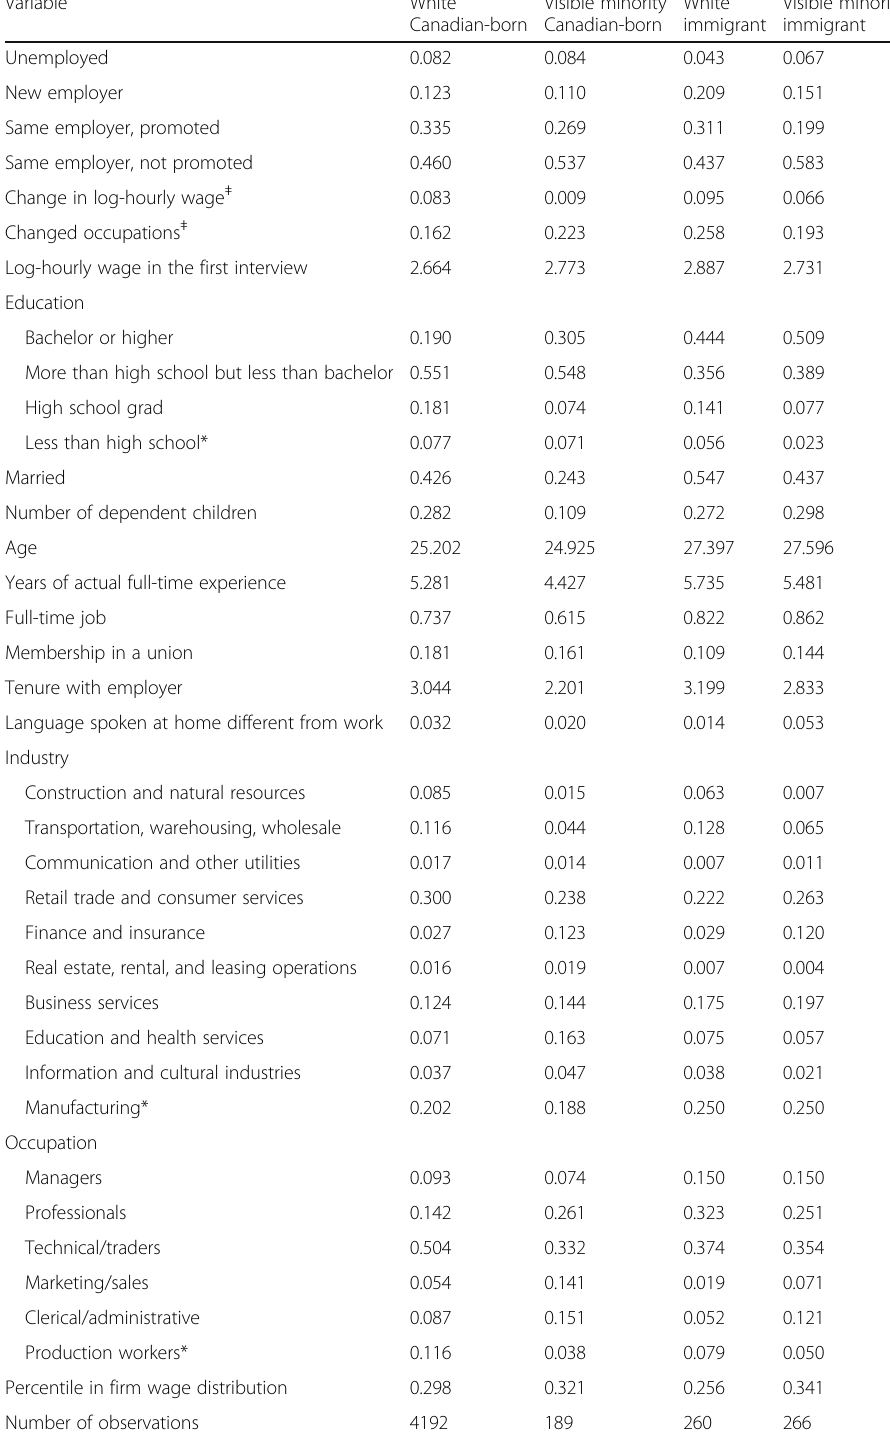
Table 1 Summary